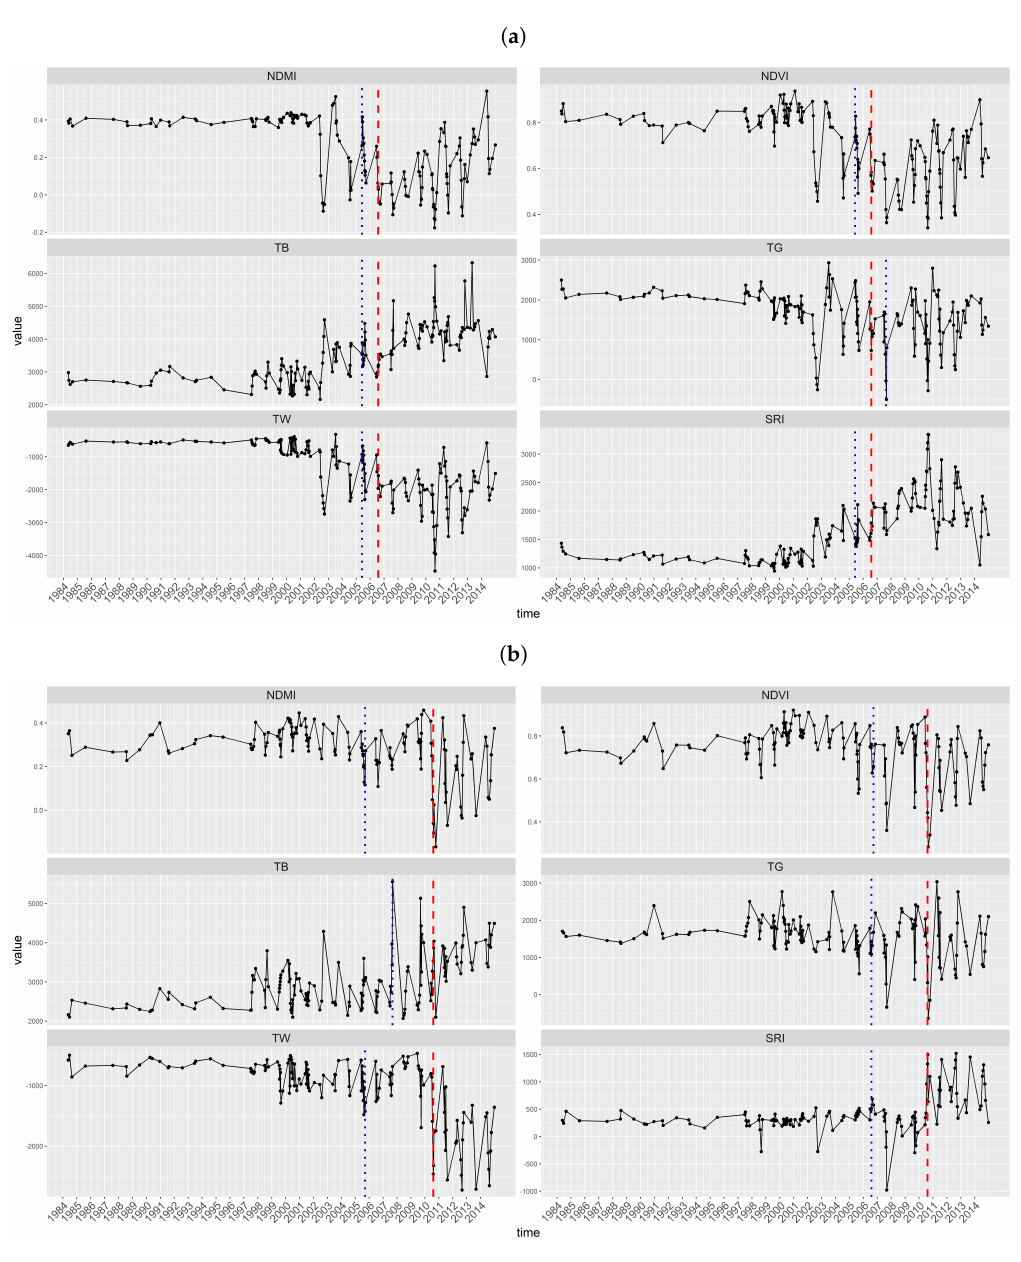
Figure 8. Time series of NDMI, NDVI, TCT and SRI at two sample locations of the Brazilian site. The red dashed line indicates real deforestation time; the blue dotted line indicates the time of MEFP detected deforestation. ( a ) Time series at location (10.345 ◦ S, 63.862 ◦ W); ( b ) time series at location (10.686 ◦ S, 63.595 ◦